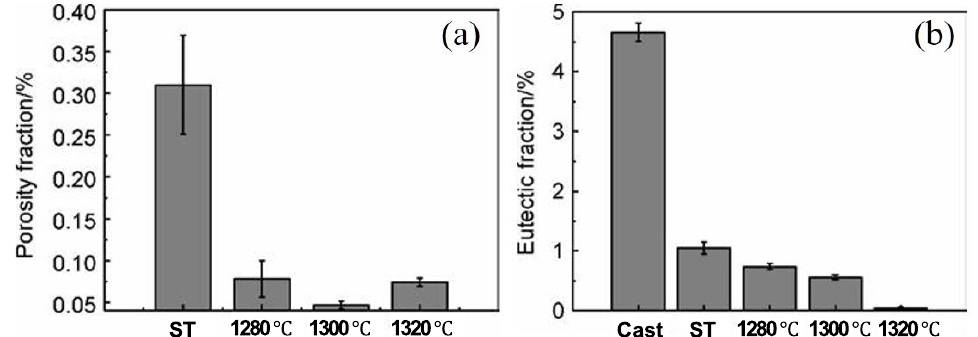
Figure 13. Micropore and eutectic content after HIP treatment with different temperature. ( a ) porosity fraction/%; ( b ) eutectic fraction/% [30].